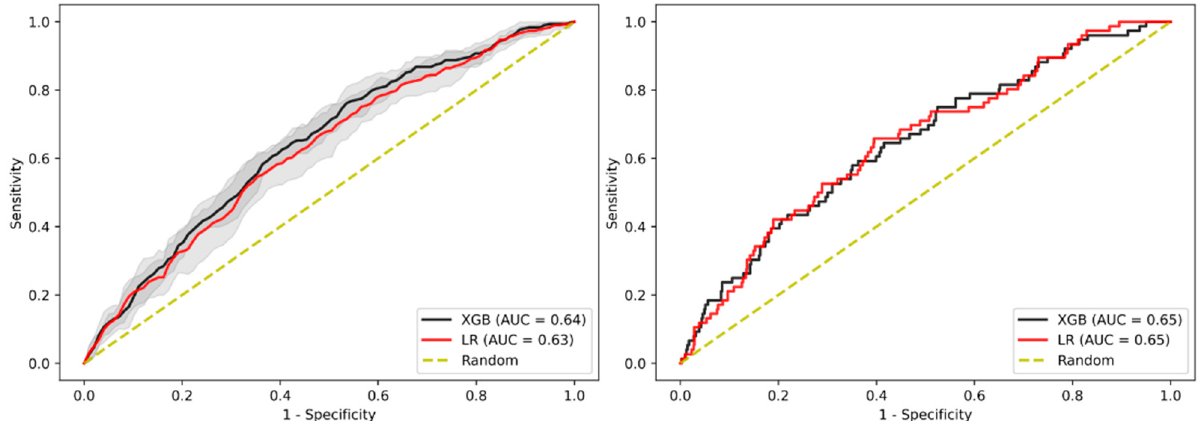
Figure 3. AUC-ROC performance of the XGBoost-based model and LR-based model to identify patients with AA when removing patients with a known family history risk. Internal validation cohort ( left ) and test cohort ( right ). Confidence intervals of 95% are shown in shaded grey.